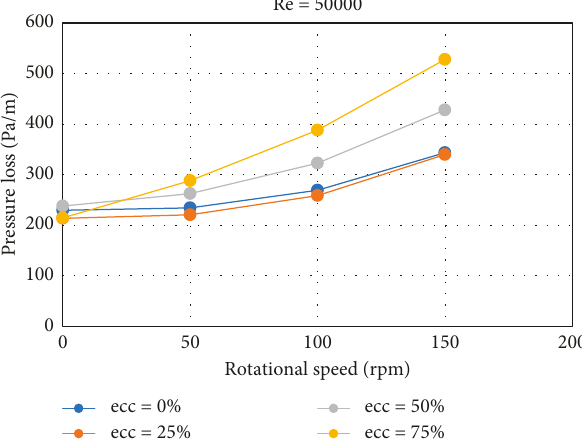
Figure 9: Effect of inner pipe eccentricity on pressure loss at different rotational speeds.